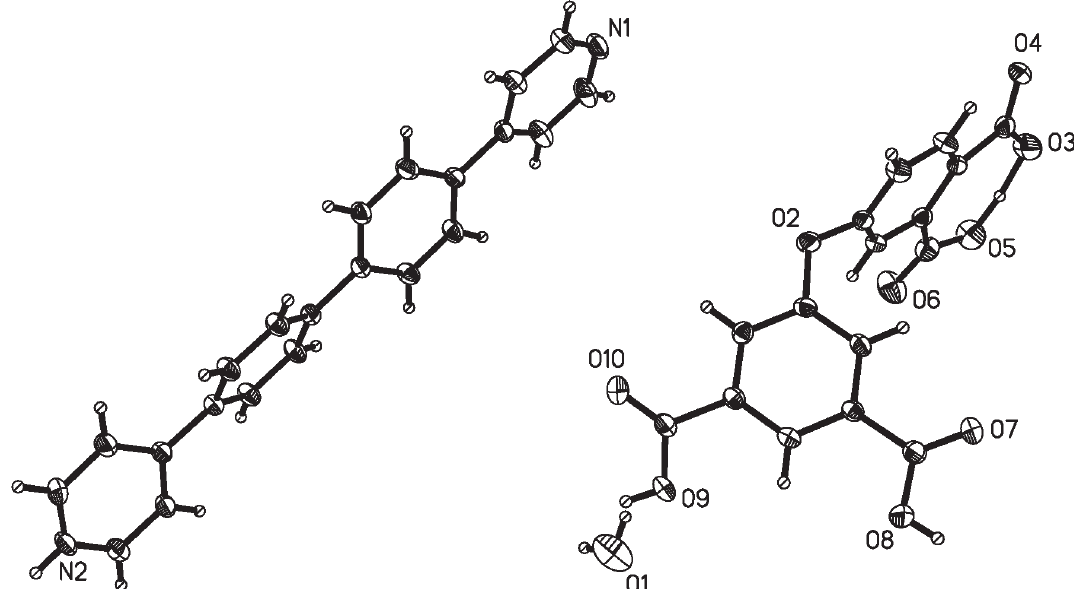
Table 1: Data collection and